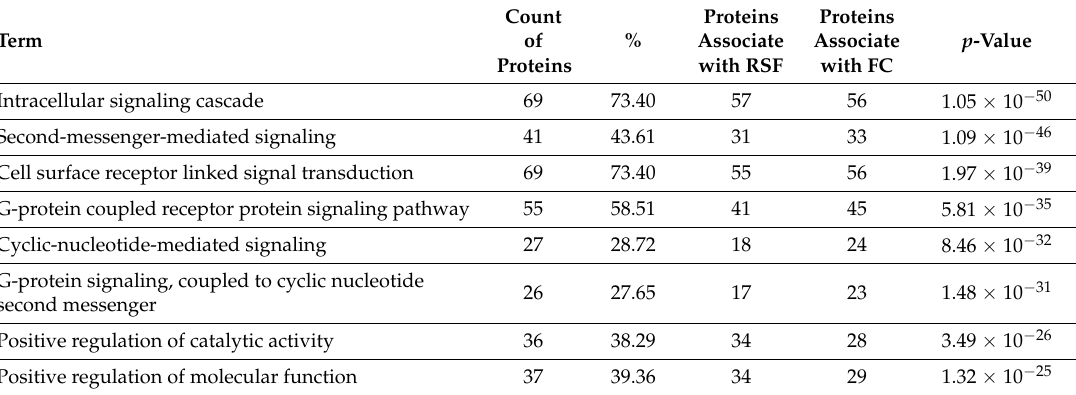
Table 1. The top 15 biological processes enriched by the 95 putative